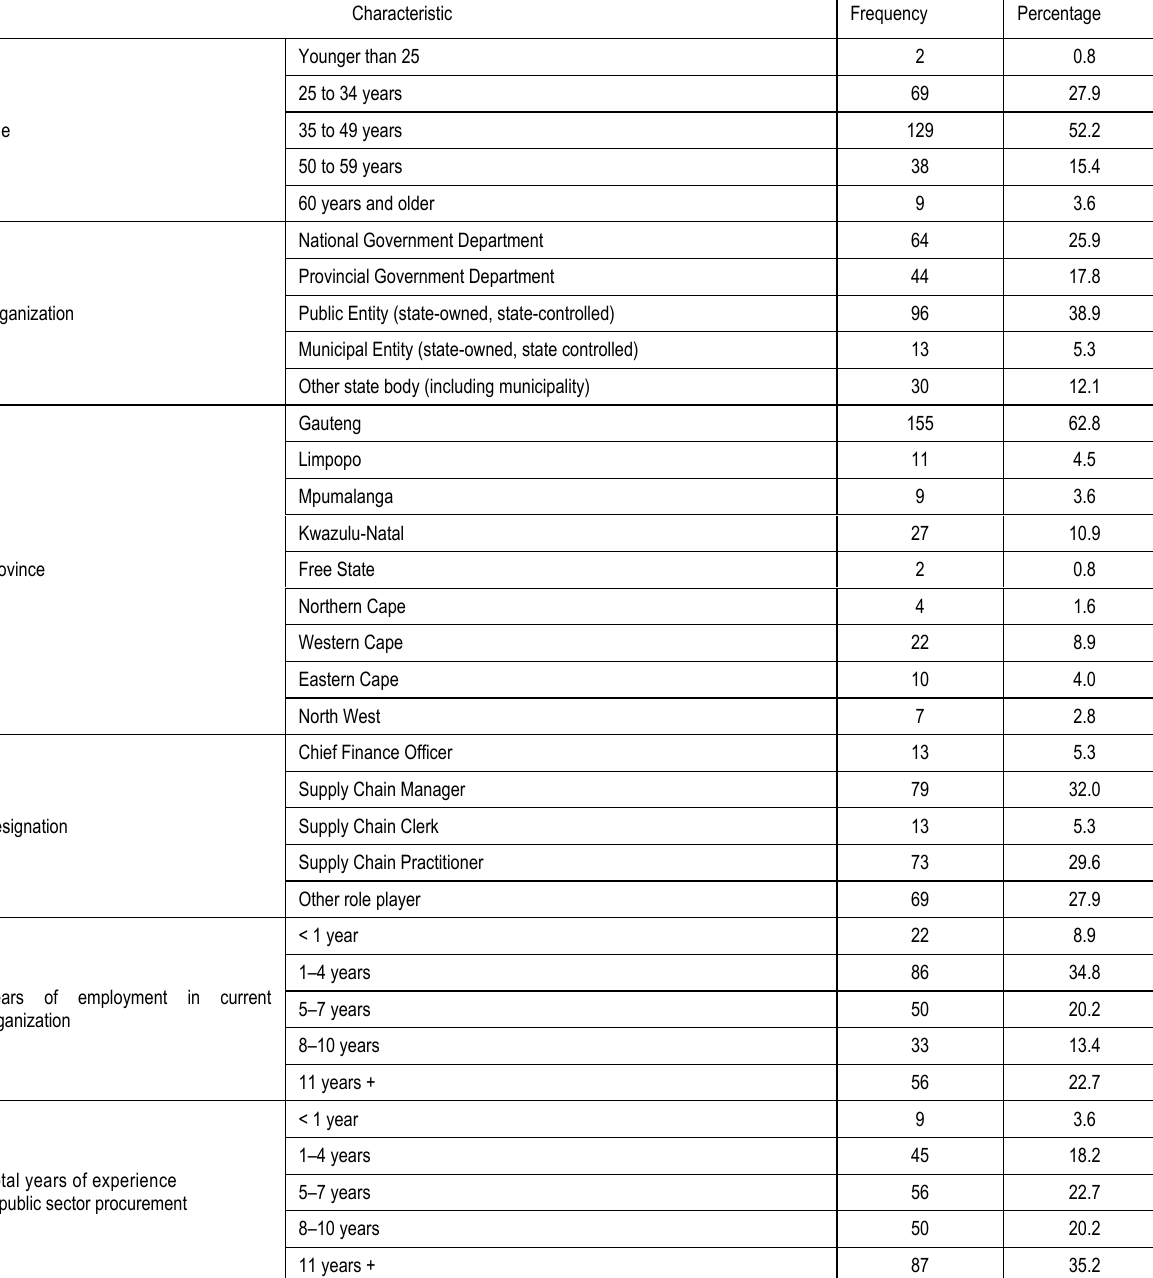
Table 3. Demographic profile of